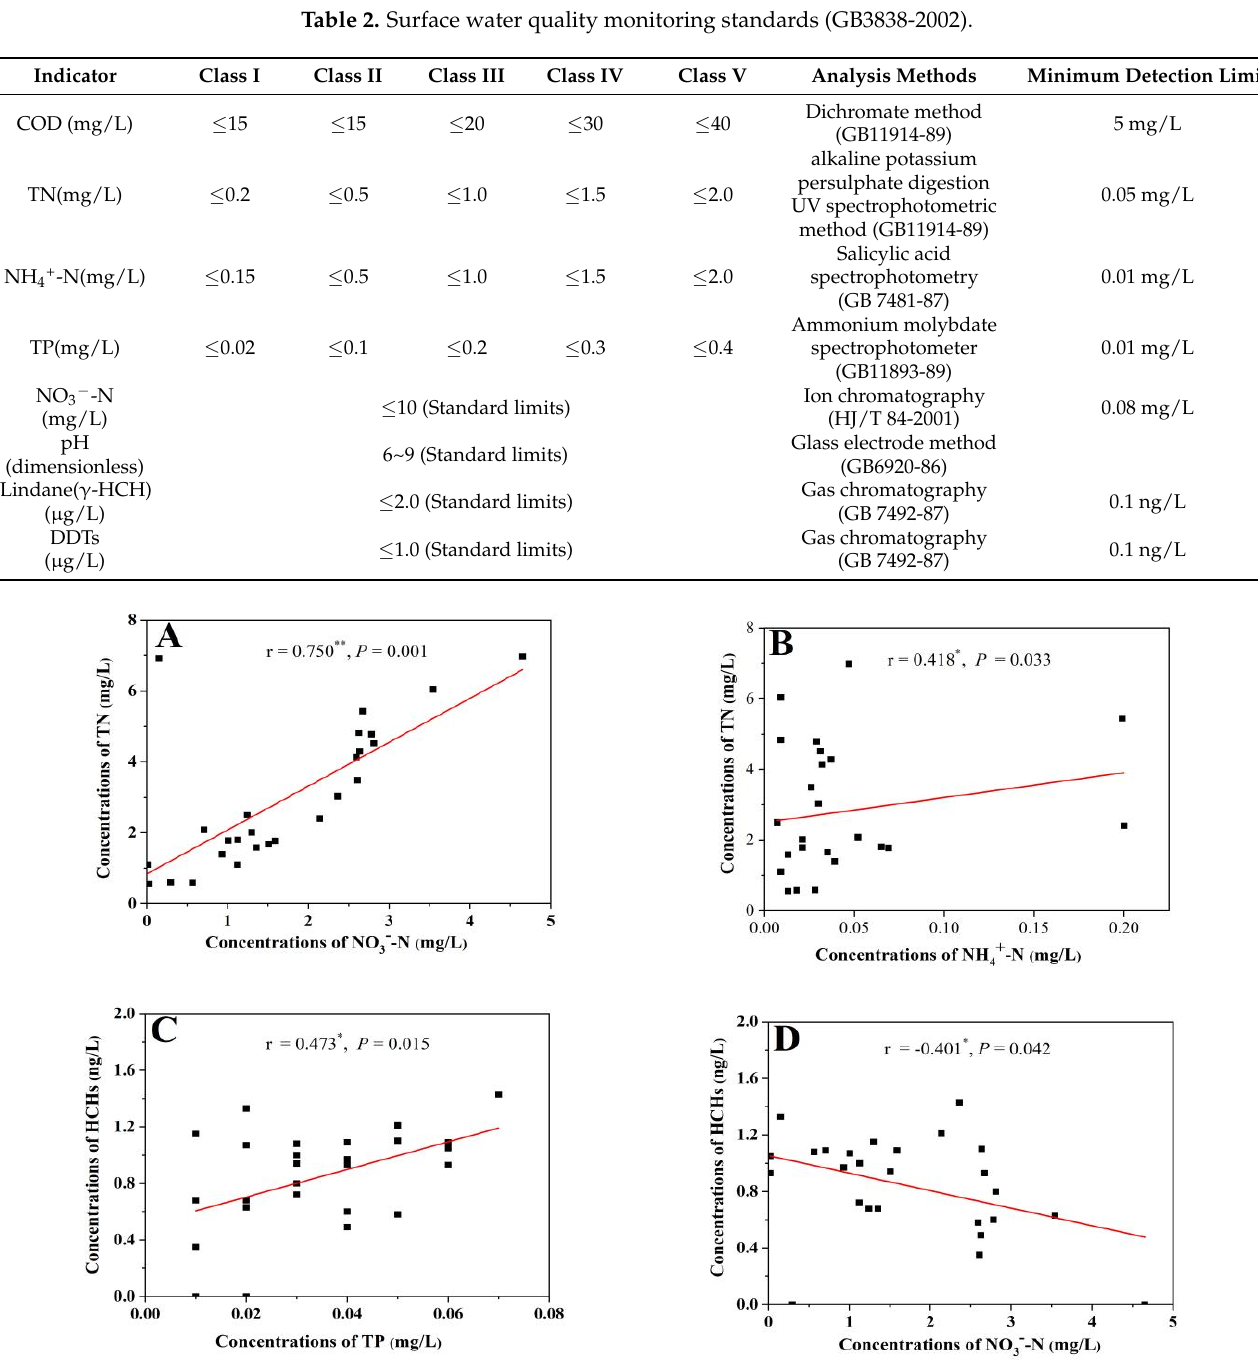
Figure 3. Correlation analysis of physicochemical indices and residues of HCHs in surface water samples from four typical crop-producing areas: ( A ) extremely positive correlation between the total nitrogen concentration and the nitrate concentration; ( B ) positive correlation between the total nitrogen concentration and the ammonium concentration; ( C ) negative correlation between the residues of HCHs and the nitrate concentration; ( D ) positive correlation between the residues of HCHs and the total P.